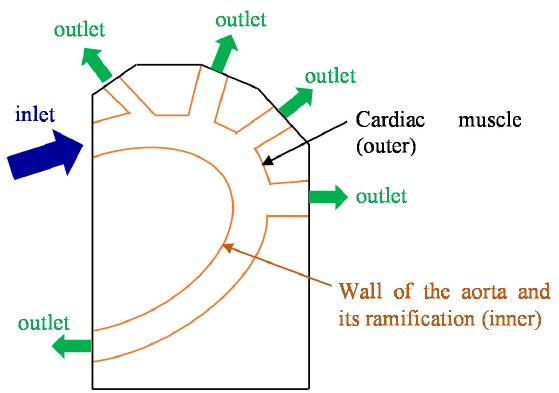
Figure 1. Schematic showing a view of the aorta, its ramifications (branching vessels), and the cardiac muscle.